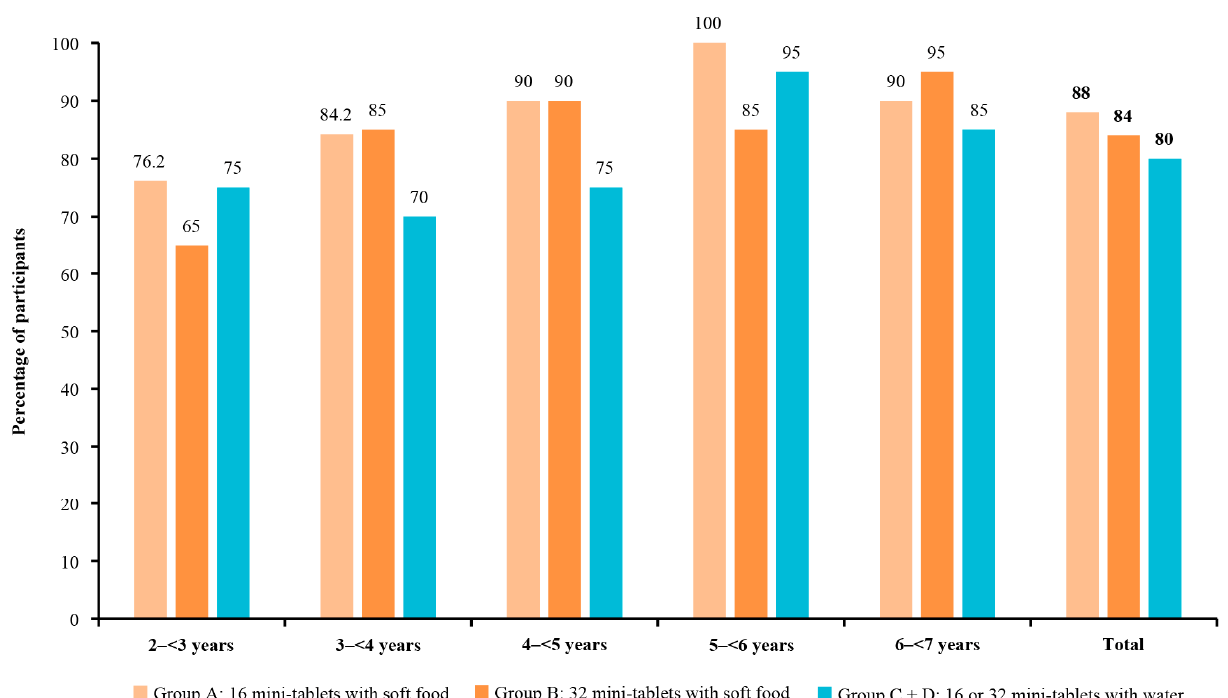
Figure 4. Acceptability of 3 mm placebo mini-tablets by age group.